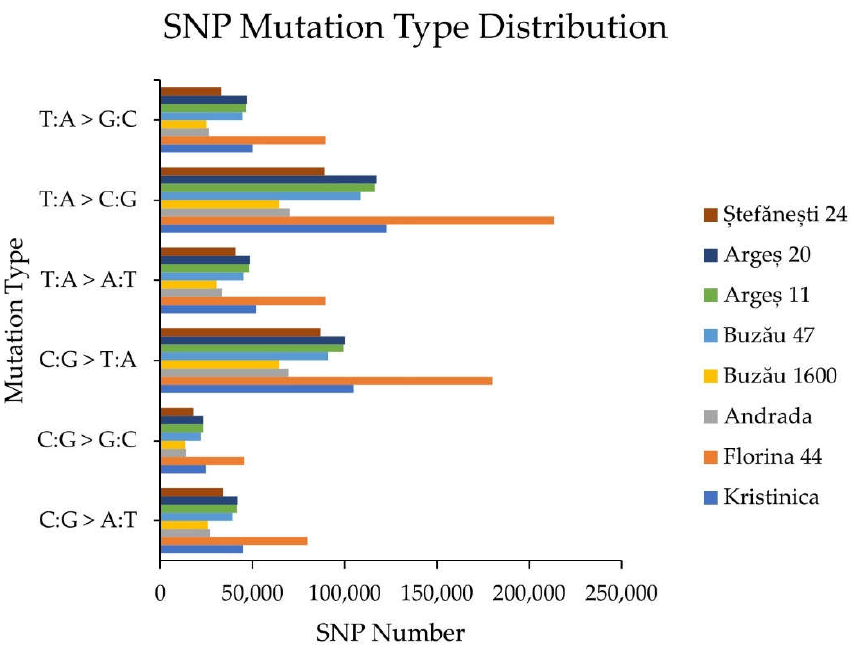
Figure 1. SNP mutation type distribution.